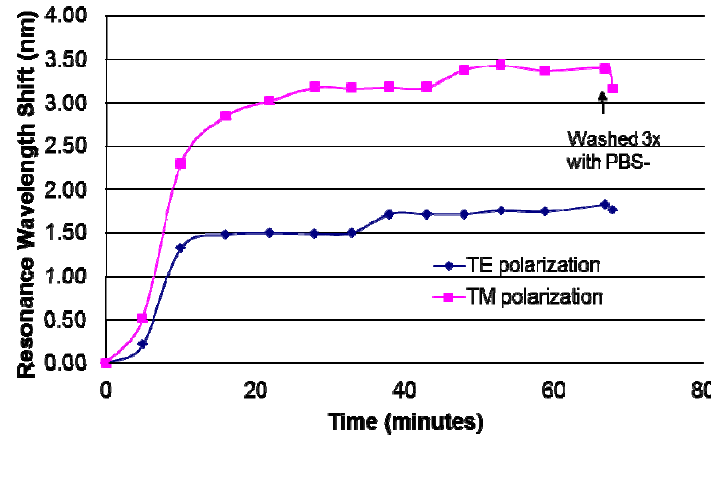
Figure 5. Illustration of the use of GMR sensor polarization diversity to quantify biotin binding (0.5 mg/mL Sulfo-NHS-LC-Biotin) to a silane-coated sensor surface. The molecular attachment event is monitored as function of time. Results for both TE and TM polarizations are shown. The results are consistent and exhibit the differing sensitivities associated with differing polarizations. At the end of the binding, any loose or unbound biotin is rinsed away in PBS-Tween